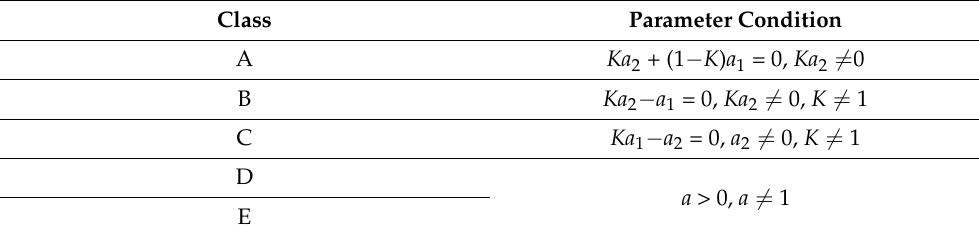
Table 3. Parameter conditions for each pattern.